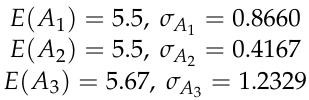
Table 4. The comparison of defuzzifying approaches in Example 2.